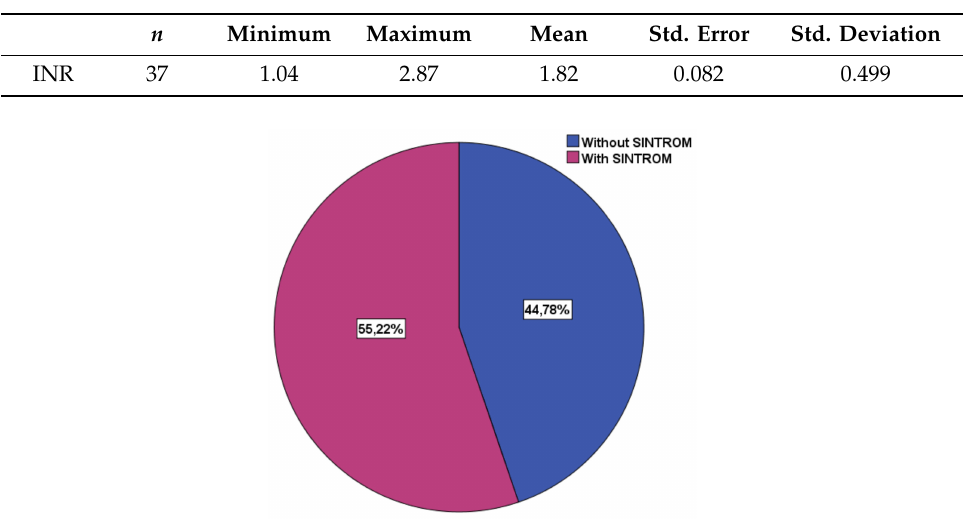
Table 7. INR Descriptive Statistics.